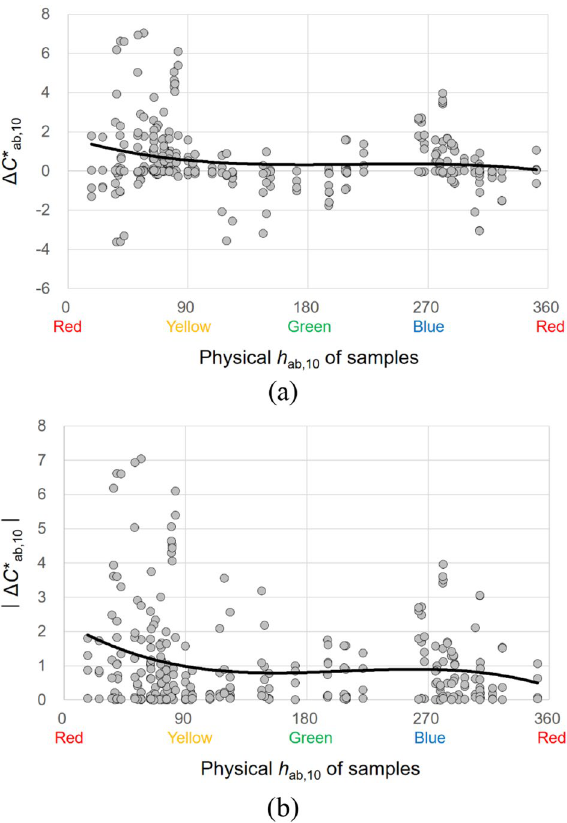
Figure 18. Effect of the physical h ab,10 of samples on their chroma appearance change, ( a ) Δ C * ab,10 and ( b ) (cid:31) (cid:31) (cid:31) (cid:31) C ∗ ab ,10 (cid:31) , under illuminants. (Δ C * ab,10 = C * A under the illuminant − spectrophotometrically measured C * ab,10